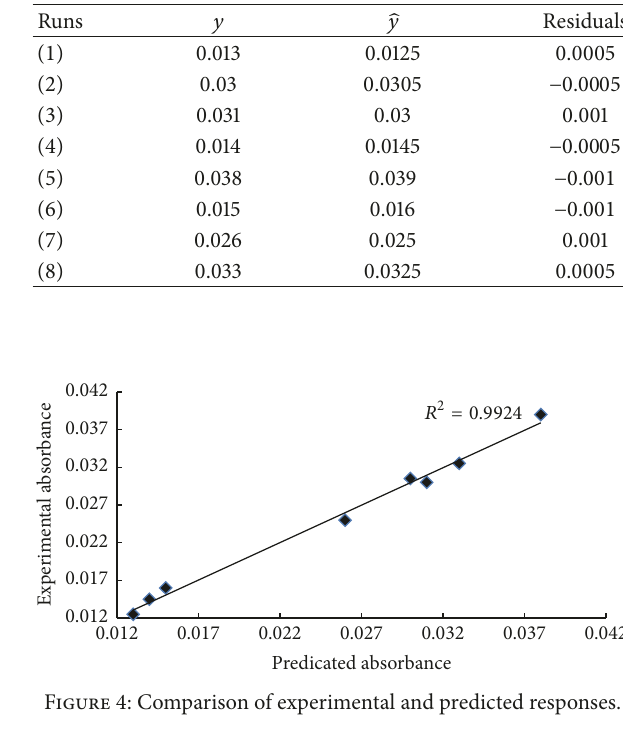
Table 6: Comparison between observed and predicted responses.